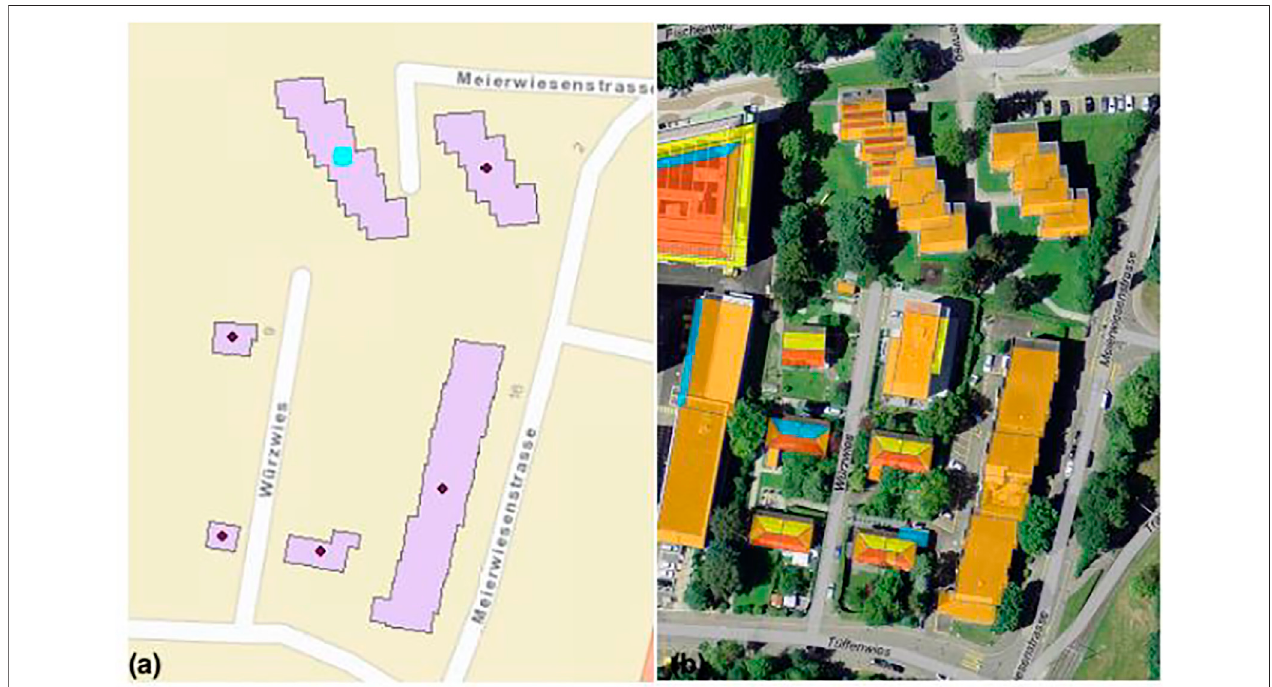
FIGURE 3 | ArcGIS 2D footprint (A) and selected roof area with high solar potentials in orange (B) of buildings in the case study district.